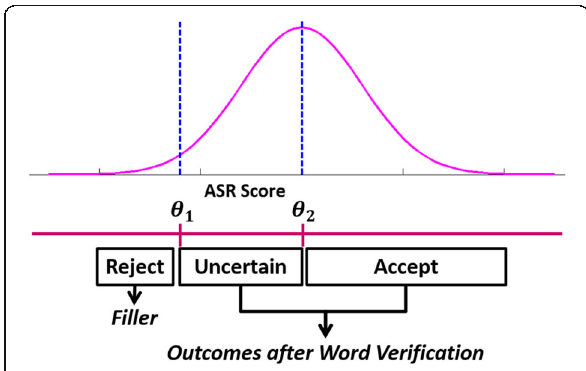
Fig. 4 Mapping between the distributions of the word verified scores and UE